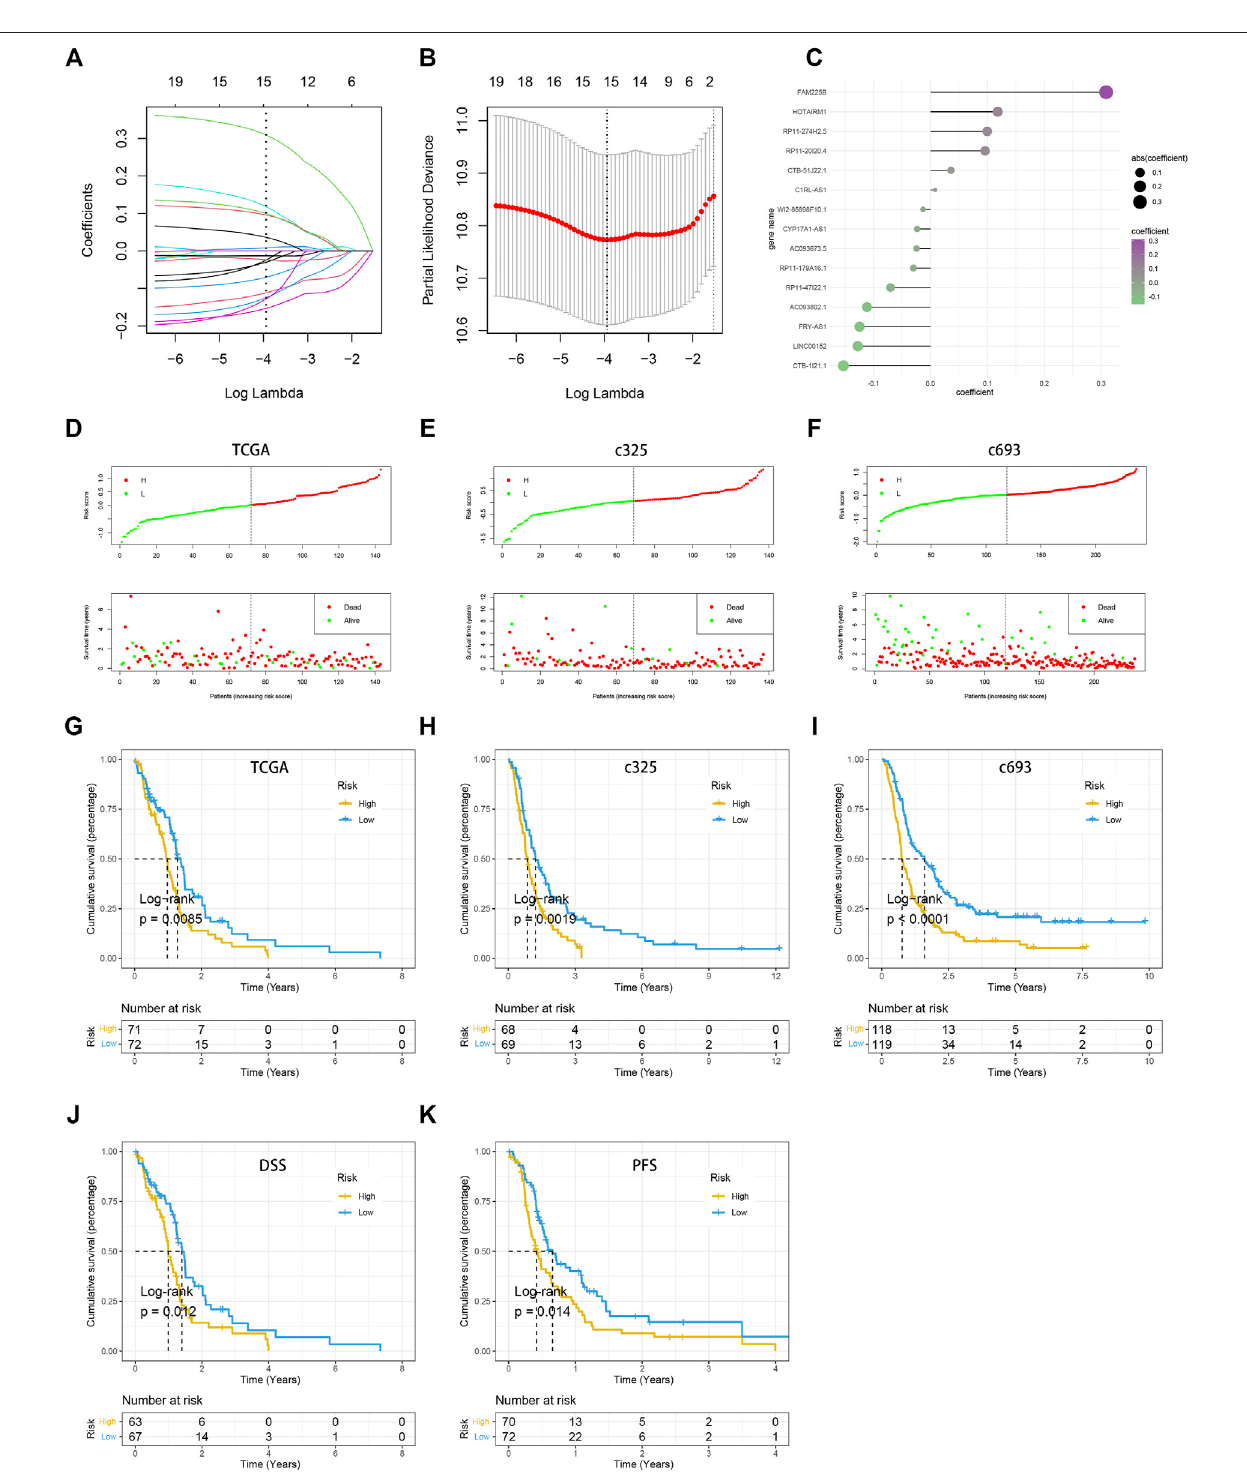
FIGURE4| Constructionofthepyroptosis-related lncRNA signature(PRLS). (A) LASSOcoef fi cient pro fi les ofthecandidate PRLsforPRLS construction. (B) Ten- timecross-validations to tune the parameter selection inthe LASSO model. The twodotted vertical lines are drawn at the optimal values by minimum criteria (left) and 1- SEcriteria (right). (C) LASSOcoef fi cientpro fi les ofthecandidategenesforRAISconstruction. (D – F) Thescattergramsoftheriskscore (up)and survivalstatus(down)of each patient in the TCGA, c325, c693 cohorts, respectively. In the upper parts of the scattergrams, the red and green dots represent high-risk ( “ H ” ) and low-risk groups( “ L ” ),respectively,andinthelowerpartofthescattergrams,deathandsurvival,respectively. (G – I) Kaplan – Meieroverallsurvival(OS)analysisofthehigh-riskand low-risk groups based on the PRLS and median risk scores in the TCGA, c325, c693 cohorts, respectively. (J) Kaplan – Meier curve of disease-speci fi c survival (DSS) in the TCGA cohort. (K) Kaplan – Meier curve of progression free survival (PFS) in the TCGA cohort.